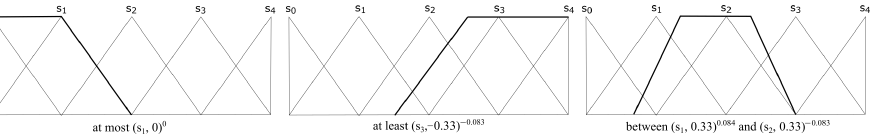
Figure 1. ELICIT expression